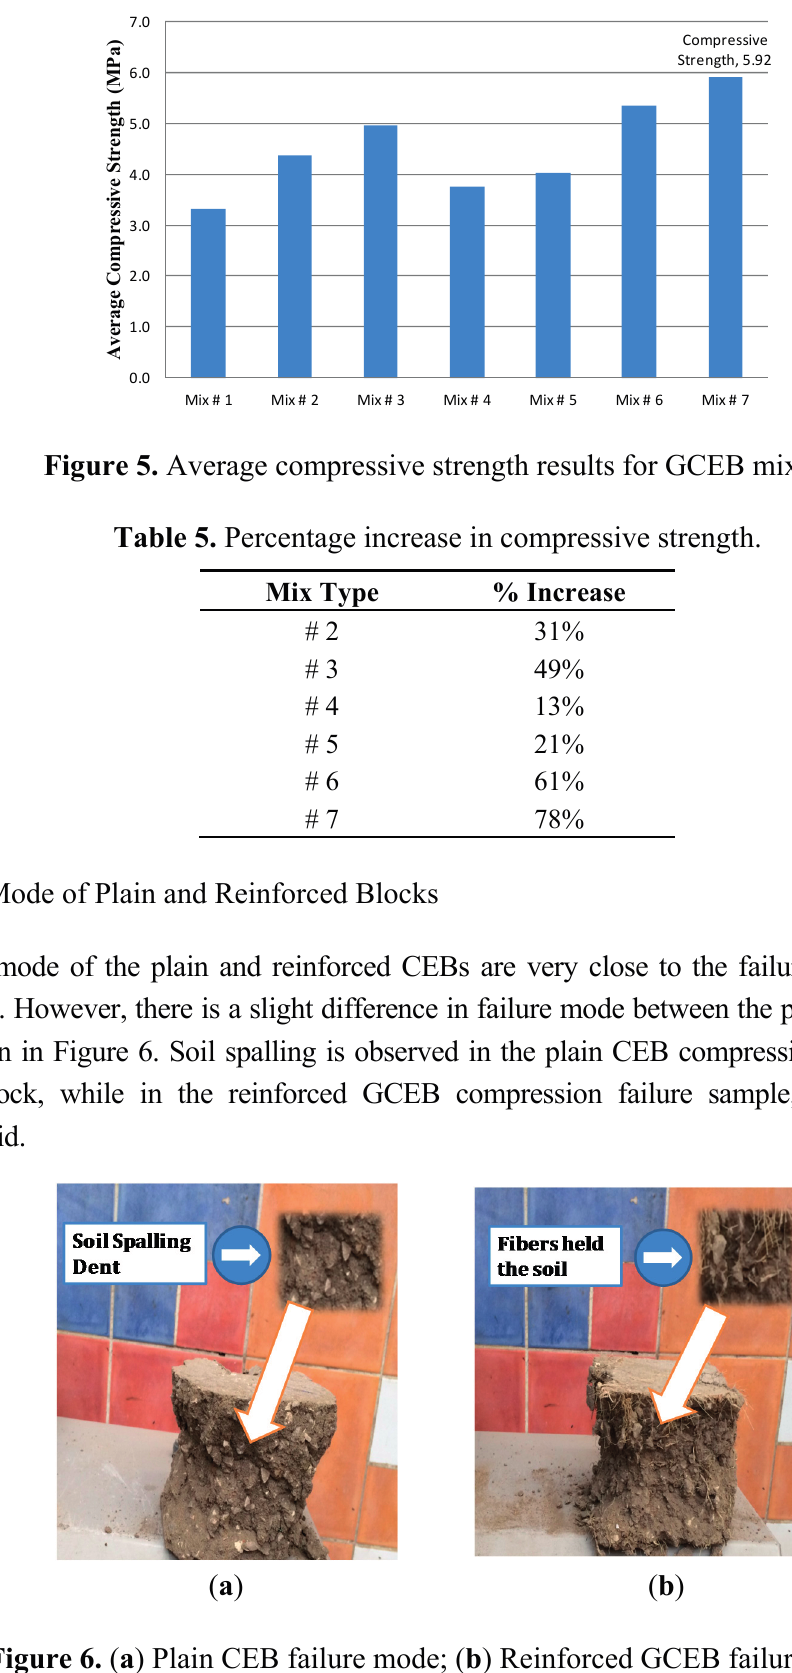
Figure 6. ( a ) Plain CEB failure mode; ( b ) Reinforced GCEB failure